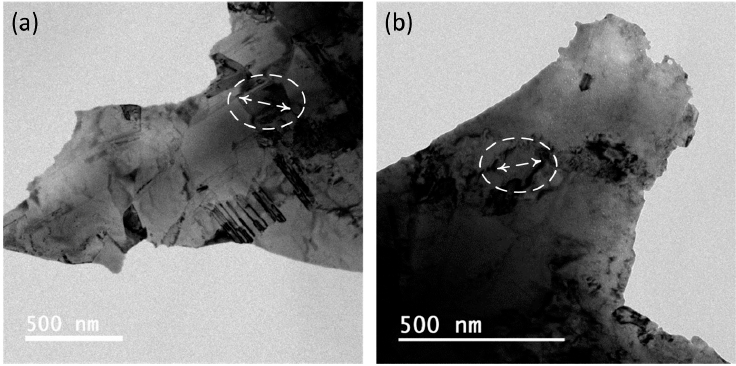
Figure 4. TEM images of the nanocrystalline: ( a ) Ag coating and ( b ) Ag-Bi coating from the plane view with individual grains highlighted in the white dotted box.